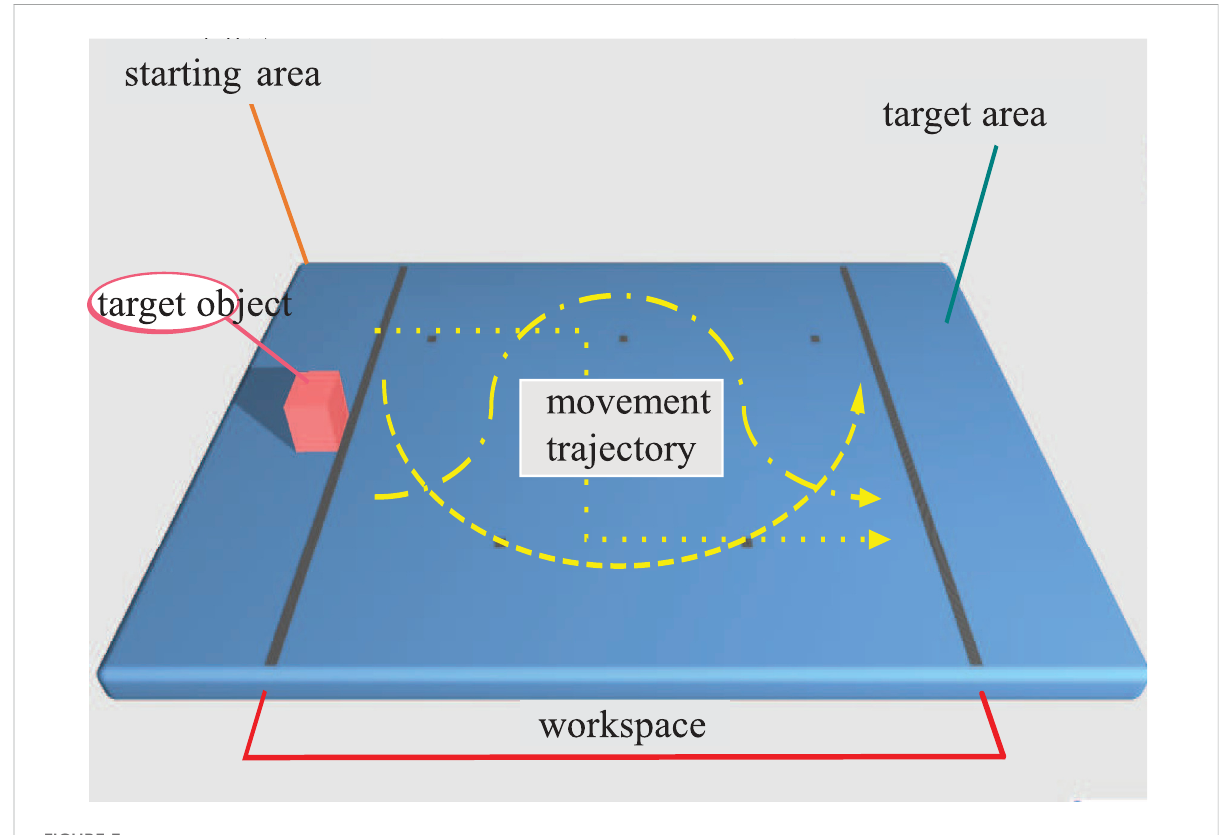
Designed interactive